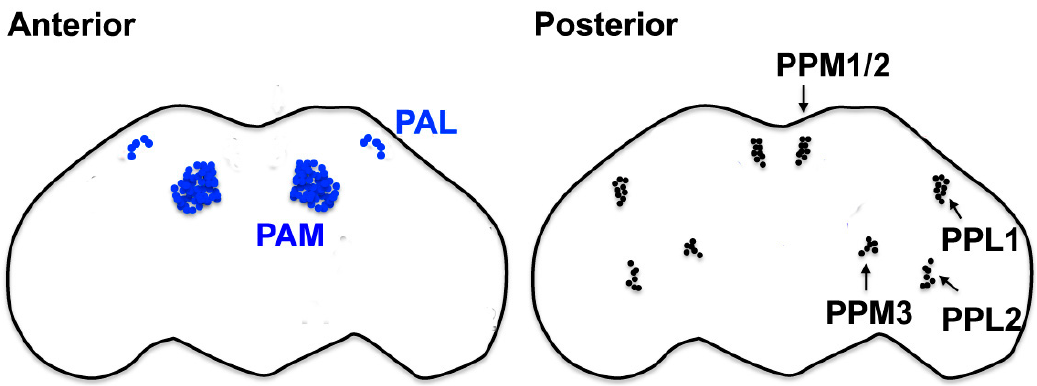
Figure 1. The dopaminergic (DA) neurons in the adult fly brain. Schematics of the seven major clusters of DA neurons located in the anterior and posterior brain [24,25,36]. The protocerebral anterior lateral (PAL) and protocerebral anterior medial (PAM) clusters reside in the anterior brain. Major posterior clusters include the protocerebral posterior medial 1, 2, and 3 (PPM1, PPM2, and PPM3, respectively) and the protocerebral posterior lateral clusters 1 and 2 (PPL1 and PPL2, respectively).